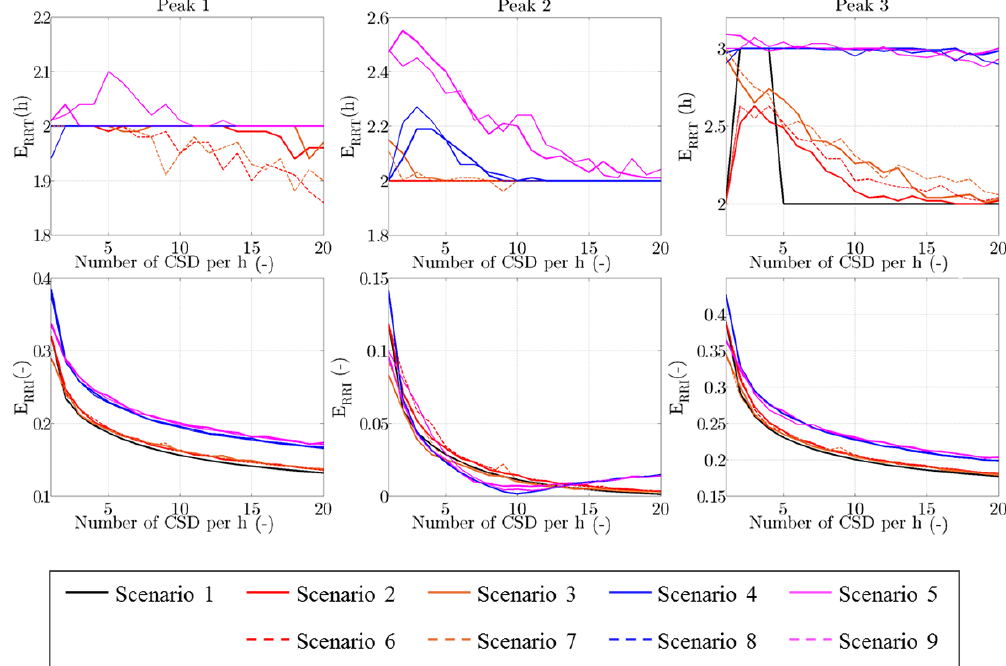
Figure 11. Representation of the errors in flood peak timing, E RRT , and intensity, E RRI , (as described in Eqs. 20 and 21), as function of the number of streamflow crowdsourced data and experimental scenarios (1 to 9), for three different flood peaks occurred during flood event 2 in the Brue